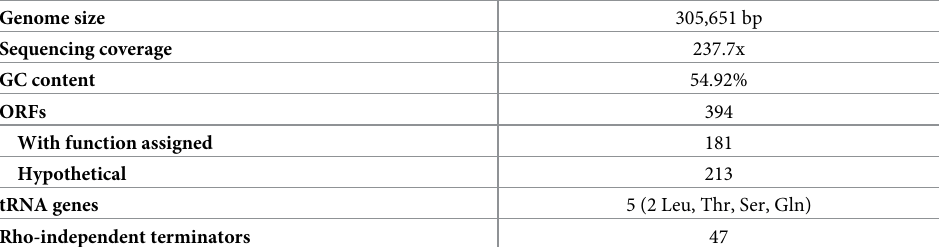
Table 2. Genomic features of